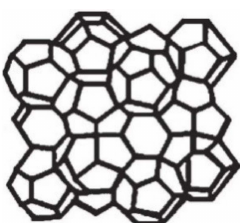
Figure 1. Structure of SBA-1. Reprinted from Reference [27] with permission from The Royal Society of